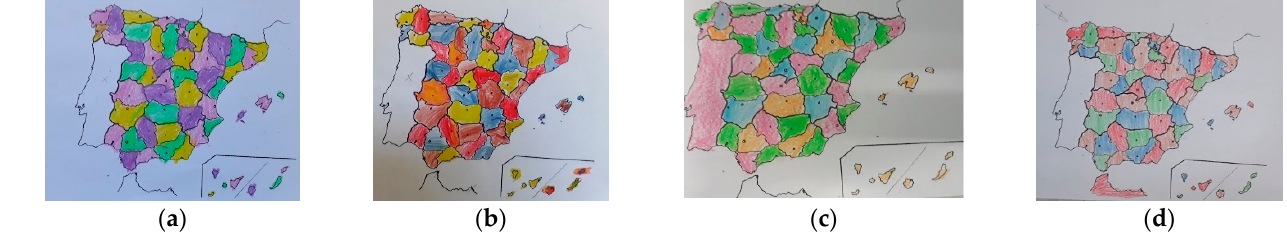
Figure 3. First attempt of coloring the map of Spain. Drawing made by participant: ( a ) A1; ( b ) A2 (orange is yellow); ( c ) A5; ( d ) A7.